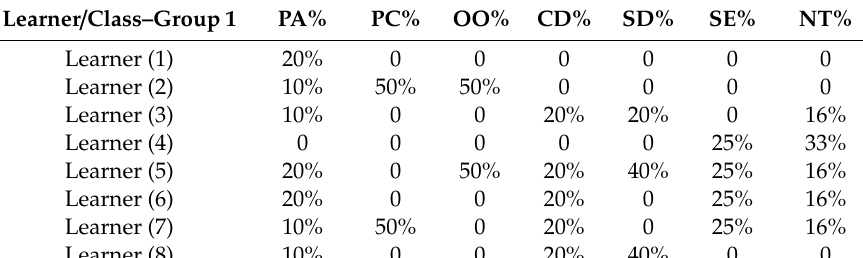
Table 15. A case study of FCS learners’ participation ratio.